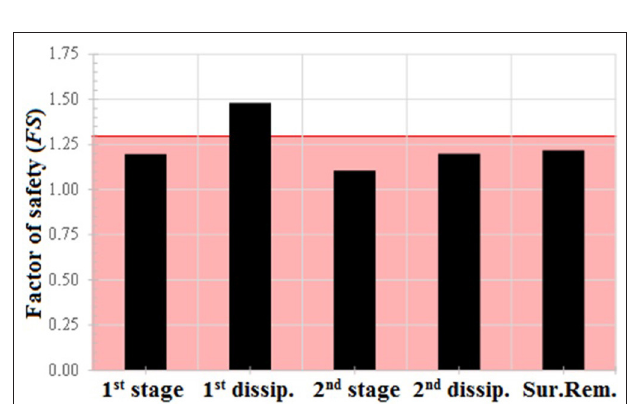
FIGURE 3 | The factor of safety ( FS ) vs. stages (SIGMA/W + SLOPE/W).